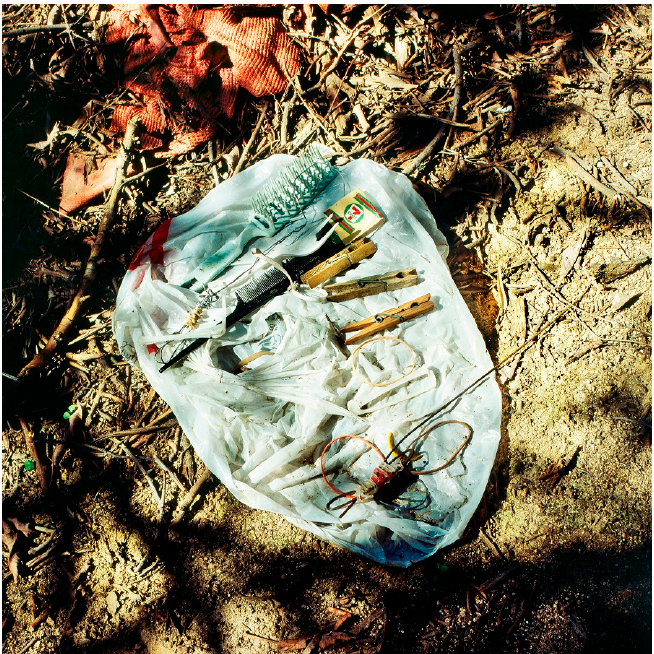
Figure 1. Anthony Hernandez, Landscapes for the Homeless #24 (1990), © Anthony Hernandez.